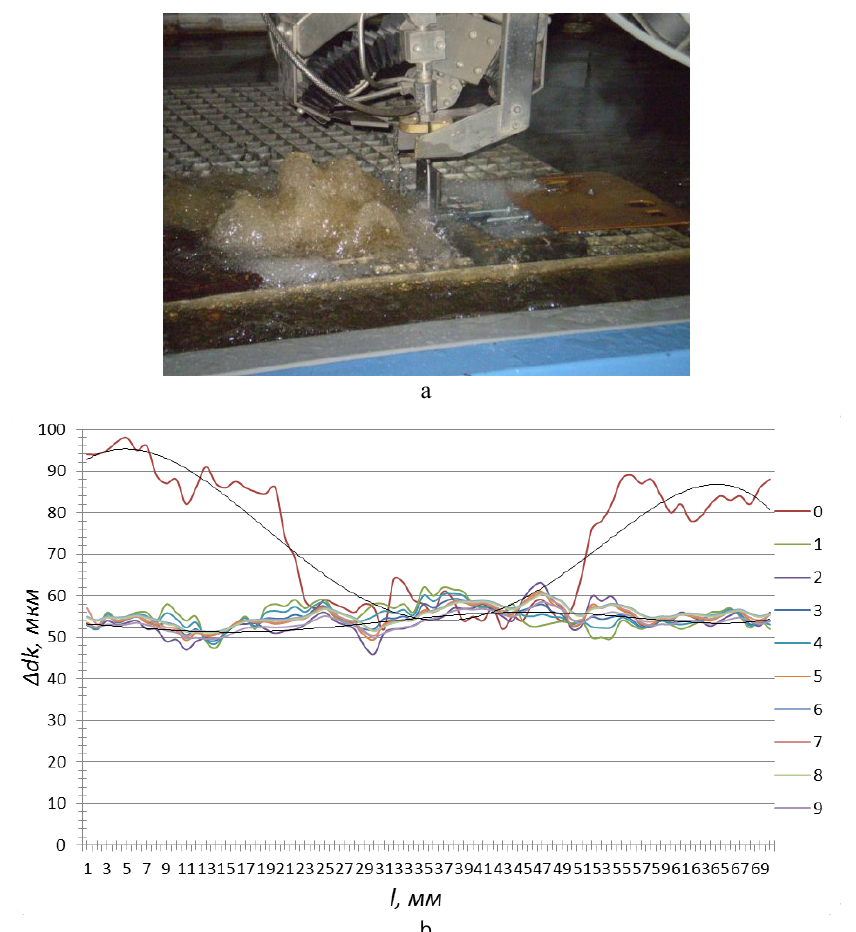
Fig. 12. Coated tubes (a) and wear profile of the channel after 10 hours of work (b): 0 – without layers; 1–9 – coated functional